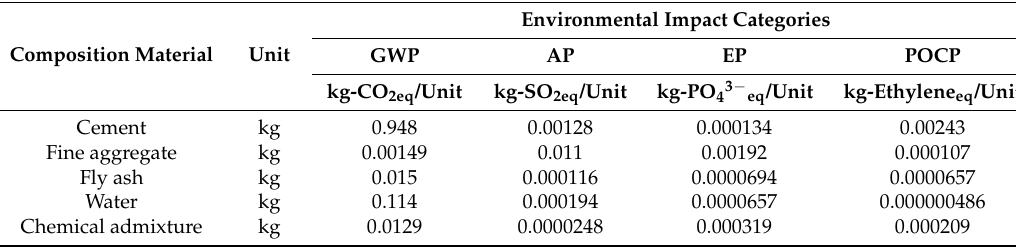
Table 4. Characterization value example of Composition material for